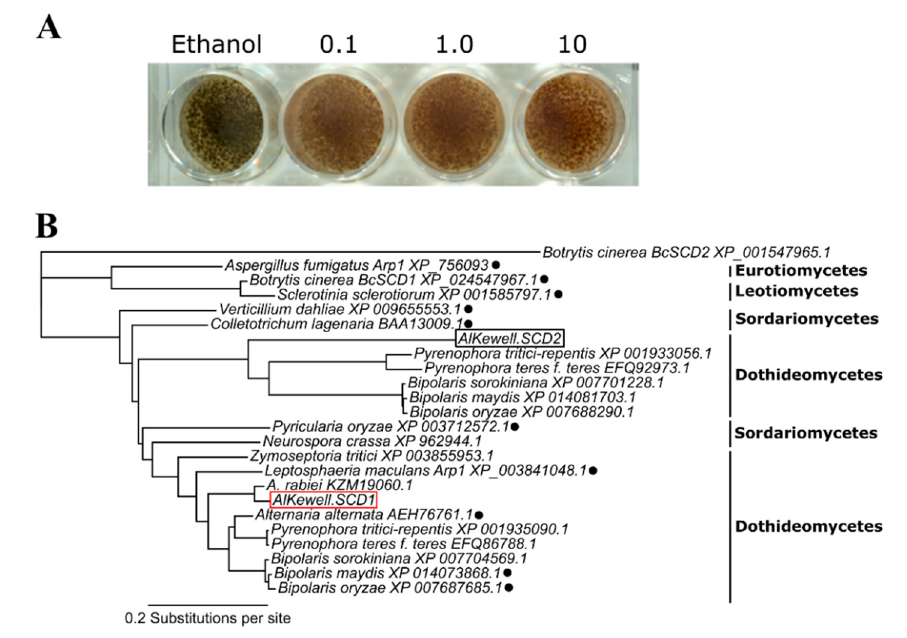
Figure 1. Identification of scytalone dehydratase ( AlSCD ) in Al Kewell ( A ) Inhibition of melanin production by tricyclazole. Representative photo from three replicates of isolates grown in 1 / 2 potato dextrose agar (PDA) supplied with di ff erent concentrations of tricyclazole after seven days of incubation. Tricyclazole concentration is expressed as µ g mL − 1 ( B ) Phylogenetic analysis of scytalone dehydratase (SCD) orthologs from di ff erent fungal isolates. SCDs that have been previously characterized are indicated by a